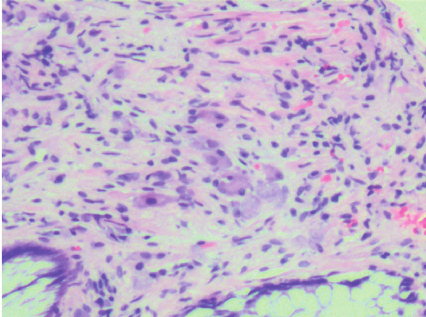
Figure 3: Hematoxylin and eosin stain of the colonic ganglioneu- roma. Ganglion and stromal cells are present in the lamina propria. Magnification: 100x.